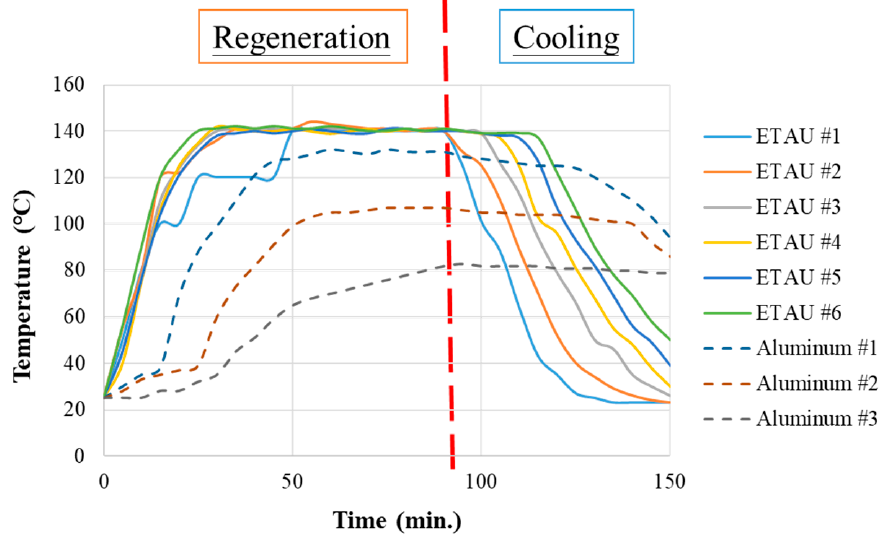
Figure 17. Temperature curves of the composite ETAU system.